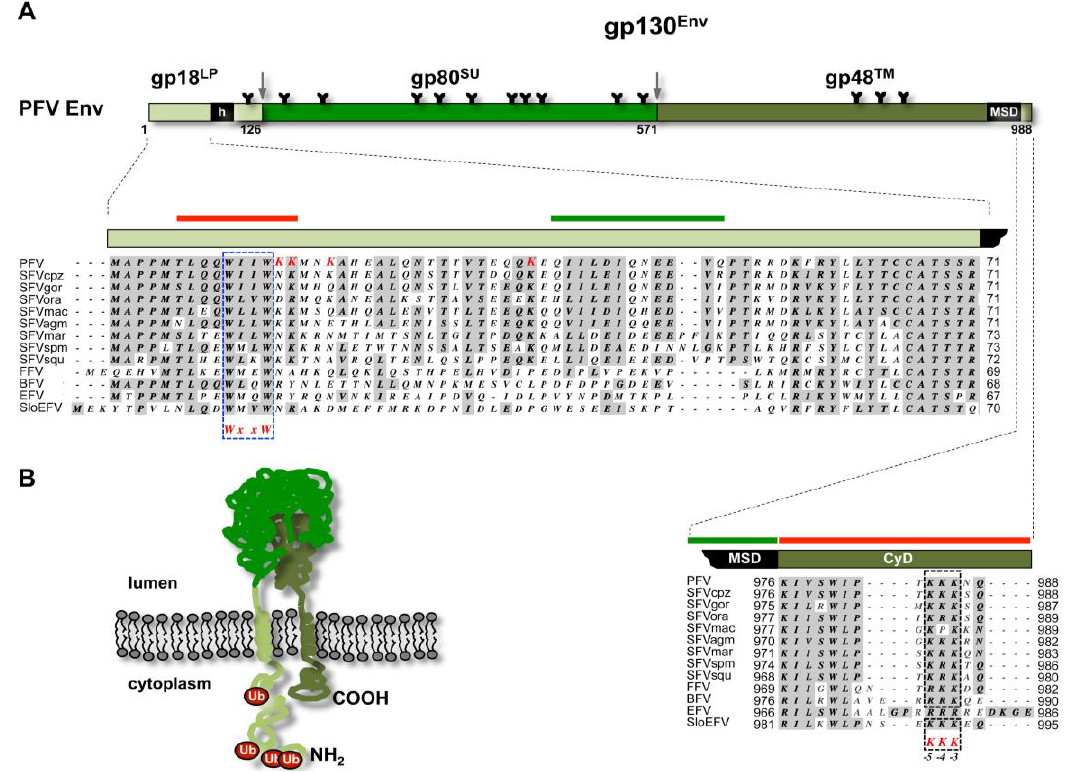
Figure 3. Foamy virus Env. ( A ) Schematic organization of PFV Env protein. The furin cleavage sites within the gp130 Env precursor that are used for generation of the mature gp18 LP , gp80 SU , and gp48 TM subunits are indicated by grey arrows. The individual subunits are shown as boxes in different shades of green. Hydrophobic sequences spanning the membrane in LP (h) and TM (MSD) subunit are indicated. Enlarged are the N-terminal cytoplasmic domain (CyD) of the LP subunit and the C-terminal CyD of the TM subunit with sequence alignment of different FV species. Domains reported to be essential for SVP release are marked by solid green bars and domains inhibiting SVP release are marked by solid red bars on top of the enlargements. Complete Env sequences of different FV species were aligned using MacVector software and Gonnet matrix. Sequence identities are shaded in grey. For the TM CyD sequences additional manual alignments were introduced to better illustrate the location of the ER retrieval signal (KKK), marked by dashed, blue boxes. The evolutionary conserved WxxW motif in the CyD of the LP subunit, important for the interaction with the capsid, is marked with a dashed, blue box. The lysine residues in PFV Env LP that were experimentally confirmed to be ubiquitinated are highlighted in red. Sequences used for alignment were retrieved from GenBank. PFV: prototype foamy virus, human foamy virus Y07725.1; SFVcpz: chimpanzee simian foamy virus, NC001364.1; SFVgor: gorilla simian foamy virus, HM245790.1; SFVora: orangutan simian foamy virus, AJ544579.1; SFVmac: macaques simian foamy virus, NC010819.1; SFVagm: African green monkey simian foamy virus, NC010820.1; SFVmar: common marmoset simian foamy virus, GU356395.1; SFVspm: spider monkey foamy virus, EU010385.1; SFVsqu: squirrel monkey foamy virus, GU356394.1; FFV: feline foamy virus, Y08851.1; BFV: bovine foamy virus, NC001831.1; EFV: equine foamy virus, NC_002201.1; SloEFV: sloth endogenous foamy virus, [23]. ( B ) Membrane topology of the PFV Env precursor gp130 Env . N-terminus (NH2) and C-terminus (COOH) are indicated. Attached ubiquitin molecules (Ub) are indicated as red